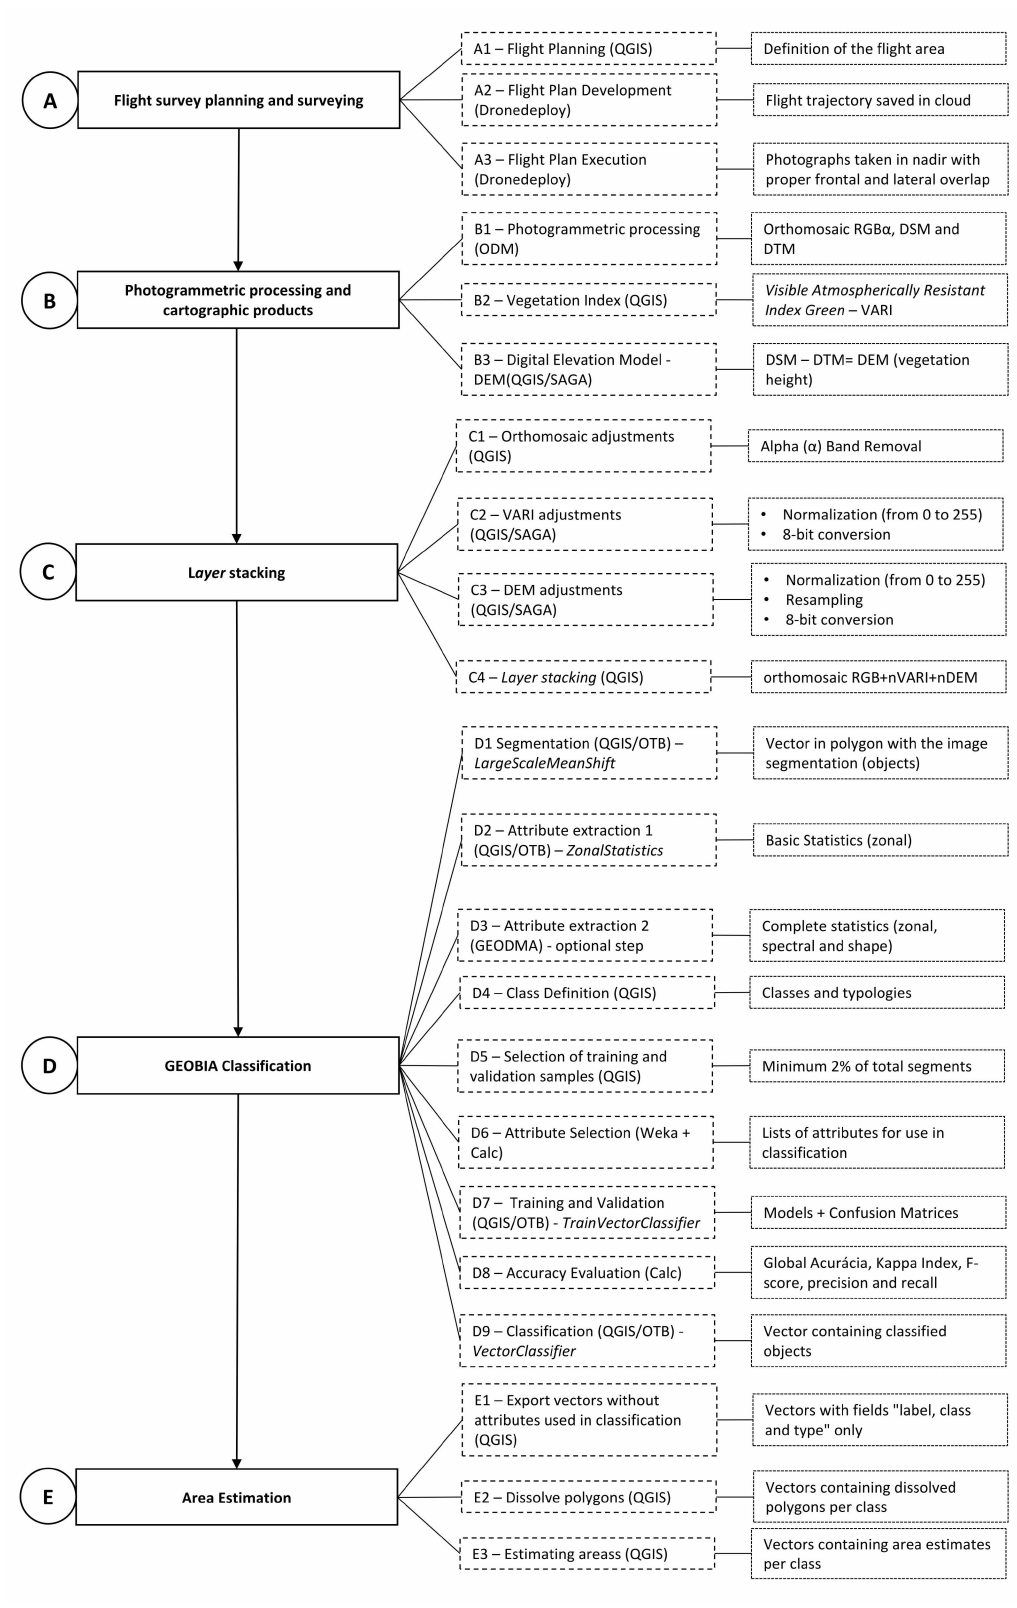
Figure 2. Methodological